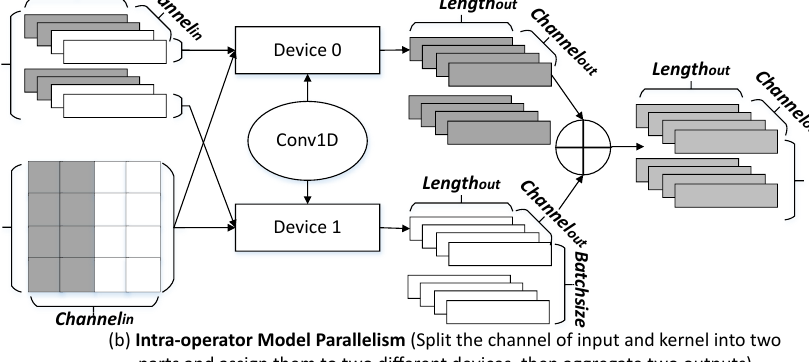
Figure 2. Schematic Diagram of intra-operator